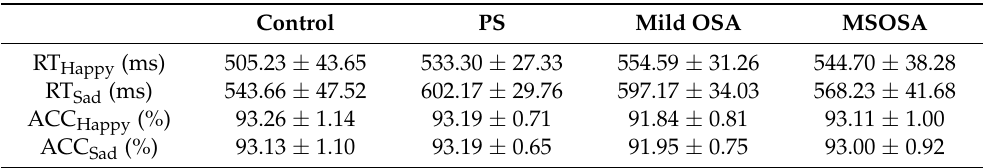
Table 2. Accuracy and reaction times of responses to different expression stimuli between the four groups (M ± SE).